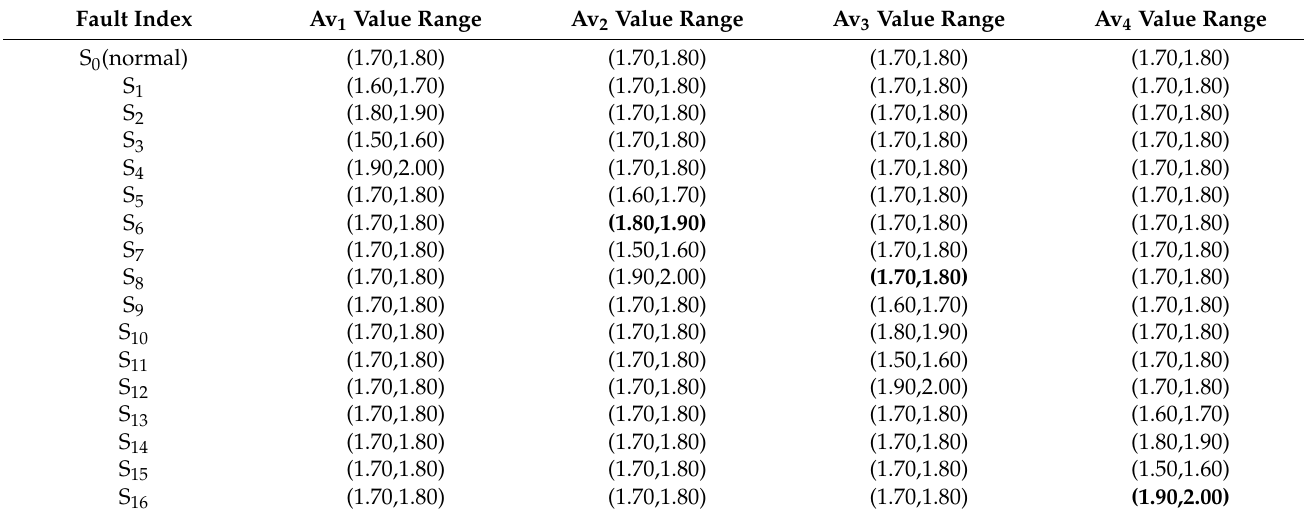
Table 2. Denotation of fault